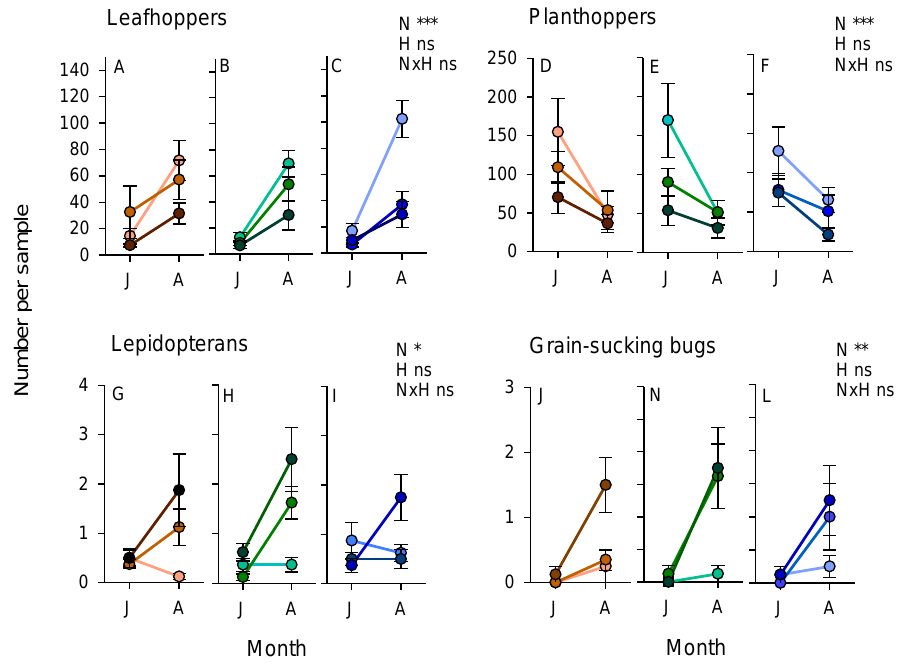
Figure 3. Relative abundance of principal rice herbivores from sweepnet sampling of rice plots during July (J) and August (A) 2011. The abundance of leafhopper vectors of tungro virus ( A – C ), planthoppers ( D – F ), lepidopterans including stemborers and leaffolders ( G – I ) and grain sucking bugs ( J – L ) are indicated. Plots were planted with IR66 and received one of three nitrogen-fertilizer treatments (indicated by color intensity of points, N1 = light, N2 = medium, N3 = dark). Samples were collected at < 3 m from clear bunds (brown lines: A, D, G, J), weedy bunds (green lines: B, E, H, N) or sesame/okra bunds (blue lines: C, F, I, L). Standard errors are indicated ( n = 8). General linear models (GLM) results for effects of nitrogen (N), bund type (H) and their interactions (N × H) are indicated for each herbivore group; ns = p > 0.05, * = p < 0.05, ** = p < 0.01, *** = p < 0.001. The abundance of predatory beetles (within subject effect (sampling period): F 1,63 = 102.088, p < 0.001), predatory bugs (F 1,63 = 62.747, p < 0.001), dragonflies and damselflies (F 1,63 = 32.670, p < 0.001), and parasitoids of planthoppers and leafhoppers (F 1,63 = 7.721, p < 0.05) increased as the crop matured, whereas the abundance of predatory flies (F 1,63 = 49.988, p < 0.001) and spiders (F 1,63 = 35.539, p < 0.001) declined as the crop matured. Parasitoids of lepidopteran herbivores and rice bugs were generally stable throughout crop development (Supplementary Figure S1). Beetles (F 2,63 = 5.160, p < 0.01) were more abundant in high-nitrogen plots, whereas spiders (F 2,63 = 5.008, p < 0.01) were more abundant in low-nitrogen plots (Supplementary Figure S1). The only apparent effect of bunds was a sampling date (rice stage) × bund interaction for predatory bugs (F 2,63 = 4.057, p < 0.05) (Figure 4). This was due to higher abundances of the predatory mirid bug, C. lividipennis , in rice plots adjacent to sesame/okra bunds during the rice reproductive stage, but a similar low abundace of the mirid in all plots (regardless of adjacent bund type) during the early crop stage (Figure 4).